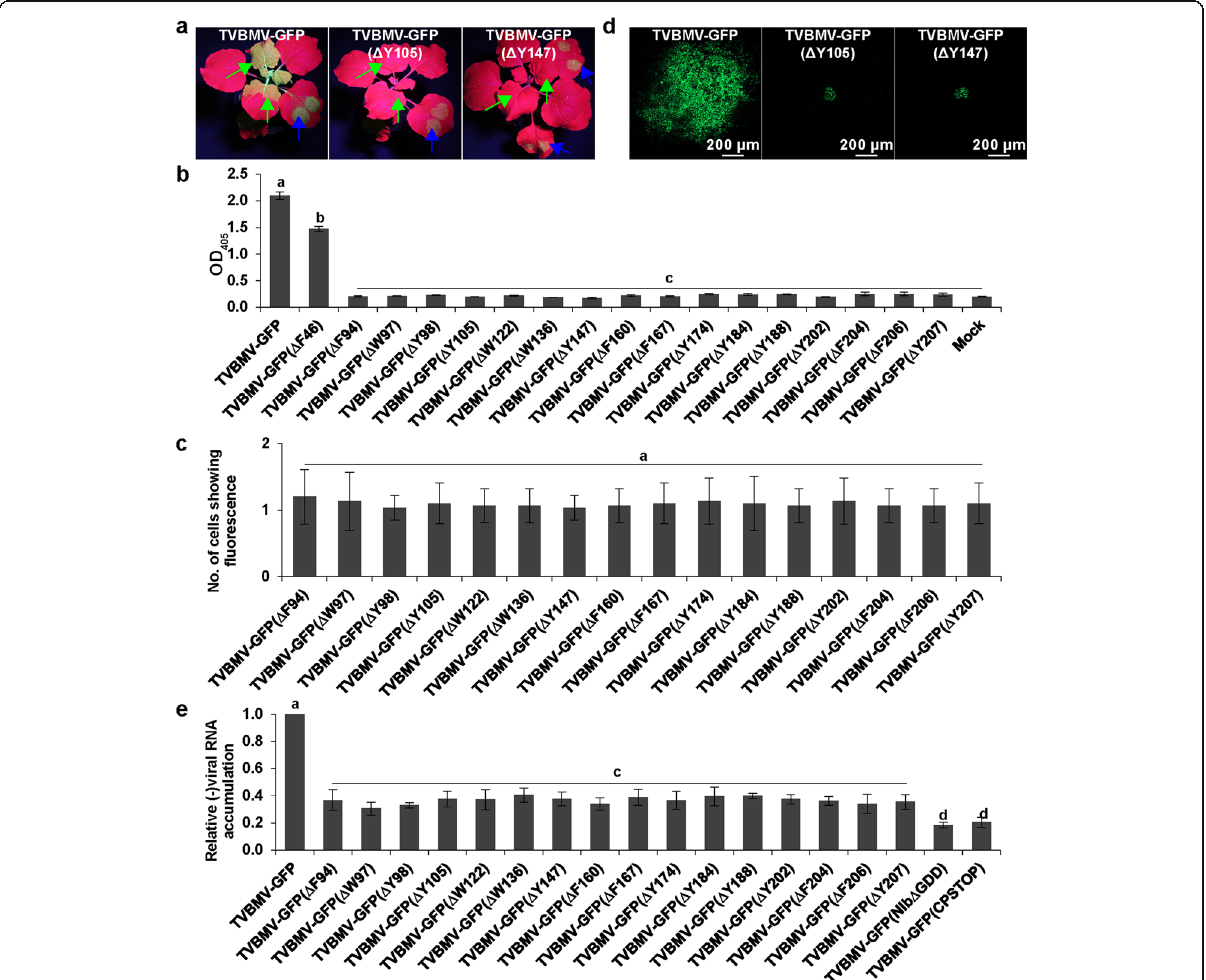
Fig. 3 Effect of π -stackings on systemic and cell-to-cell movement, and replication of TVBMV. a Systemic movement of TVBMV-GFP, TVBMV-GFP ( Δ Y105) and TVBMV-GFP ( Δ Y147). GFP fluorescence in the systemic leaves of N. benthamiana plants inoculated with the virus was observed under UV light at 7 dpai. Blue and green arrows indicate the infiltrated and systemic leaves, respectively. b Viral accumulation was detected by ELISA in the systemic leaves of N. benthamiana plants inoculated with TVBMV-GFP, one of its 16 mutants derived from aromatic residues (F 94 , W 97 , Y 98 , Y 105 , W 122 , W 136 , Y 147 , F 160 , F 167 , Y 174 , Y 184 , Y 188 , Y 202 , F 204 , F 206 and Y 207 ) that were predicted to form π -stacking, or TVBMV-GFP ( Δ F46) at 7 dpai. A sample from a buffer-inoculated plant was used as a negative control (Mock). c Cell-to-cell movement of 16 viral mutants in the infiltrated leaves at 5 dpai. The number of cells showing GFP fluorescence was the means ± SD from 30 infection foci per treatment. d Cell-to-cell movement of TVBMV-GFP, TVBMV-GFP ( Δ Y105), and TVBMV-GFP ( Δ Y147). GFP fluorescence was observed under a confocal microscope at 5 dpai. e The replication levels of TVBMV-GFP, viral mutants derived from 16 aromatic residues, and replication-defective mutants TVBMV-GFP (NIb Δ GDD) and TVBMV-GFP (CPSTOP). The minus-strand ( − )RNA accumulating level in the infiltrated leaf patches was detected by RT-qPCR at 60 hpai. The expression level of NbEF1A was used as an internal control. The values are the means ± SD from three biological replicates per treatment. Treatments marked with the same lowercase letters have no significant statistical difference. The inoculation tests were repeated three times independently. The viral systemic and cell-to-cell movement in the plants inoculated with the other 14 aromatic mutants were the same as those in the plants inoculated with TVBMV-GFP ( Δ Y105) and TVBMV-GFP ( Δ Y147) (data are not shown). ‘ Δ ’ indicates the codon for the residue